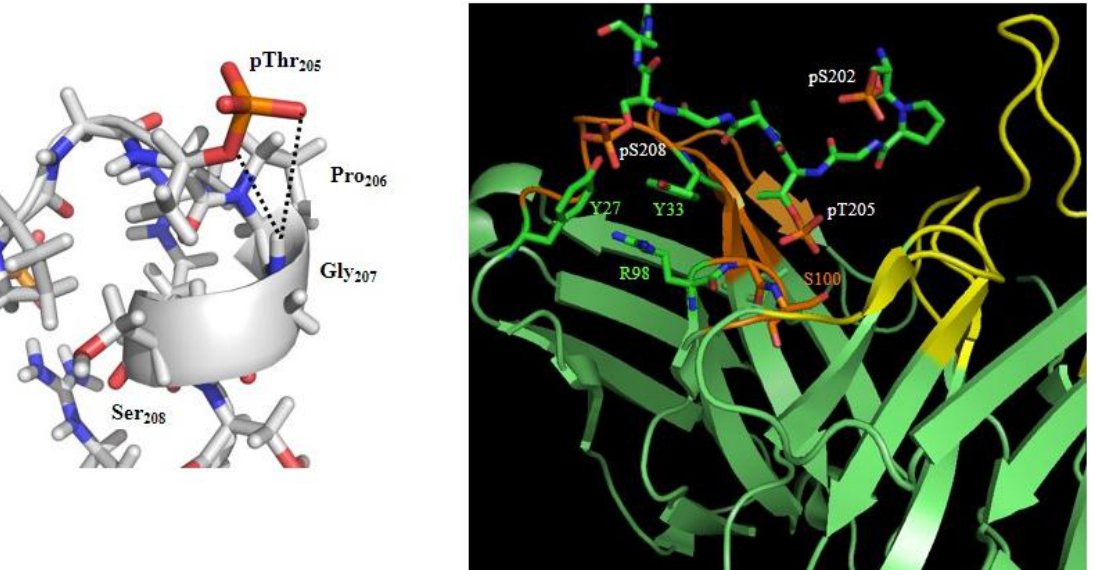
Figure 5. Structure of the AT8 motif in solution [56] or in complex with the AT8 Fab fragment ([142]; PDB code 5E2W). The helical turn stabilized by the interaction between the Gly 207 HN and the phosphate group of pThr 205 (left) is not maintained in its complex with the AT8 antibody (right). The phosphate group of pSer 208 makes additional interactions with residues of the antibody. The AT8 Fab is in green, with the variable loops of the light and heavy chain in yellow, respectively, orange.